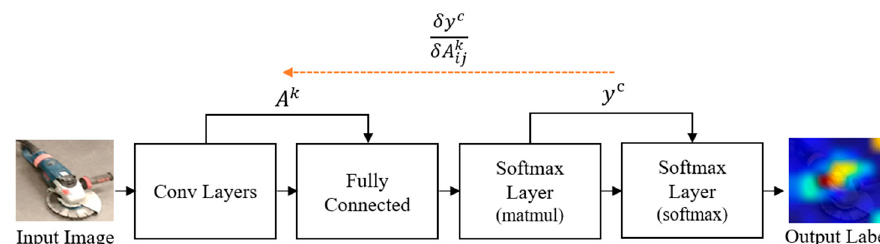
Figure 3. Grad-CAM architecture.